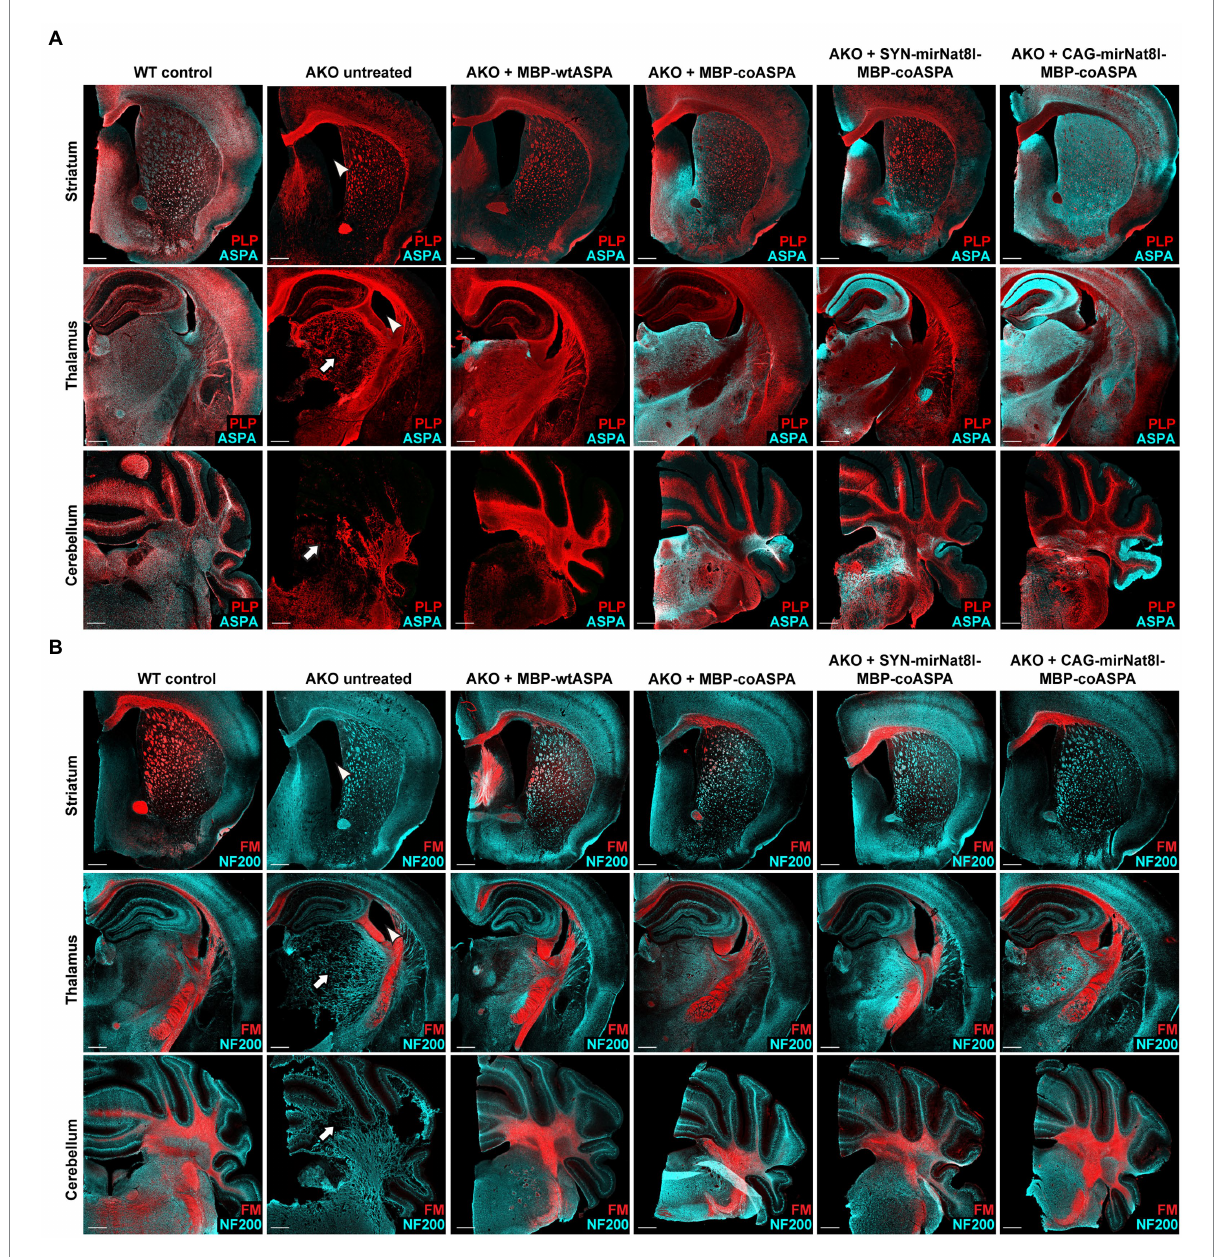
FIGURE 9 Treatment with novel CD gene therapy vectors restores ASPA expression and improves myelination in AKO mice. AAV vectors were injected bilaterally into striatum, thalamus, and cerebellum (3 × 10 9 vg per site) of 12-week-old post-symptomatic AKO mice. Coronal brain sections from the AAV injected regions (striatum, thalamus and cerebellum) were immunolabelled 40 weeks after gene therapy. (A) Immunohistochemistry for ASPA (cyan) and PLP (red) to visualize vector spread and myelin integrity, respectively. Untreated AKO mice display enlarged ventricles (arrowheads) and spongiform vacuolization (arrows), both of which significantly improved following gene therapy. (B) Co-labelling with the neuronal marker NF200 (cyan) and FluoroMyelin Red (FM; red) showing improved myelination following AAV treatment. Scale bars: 500 μ